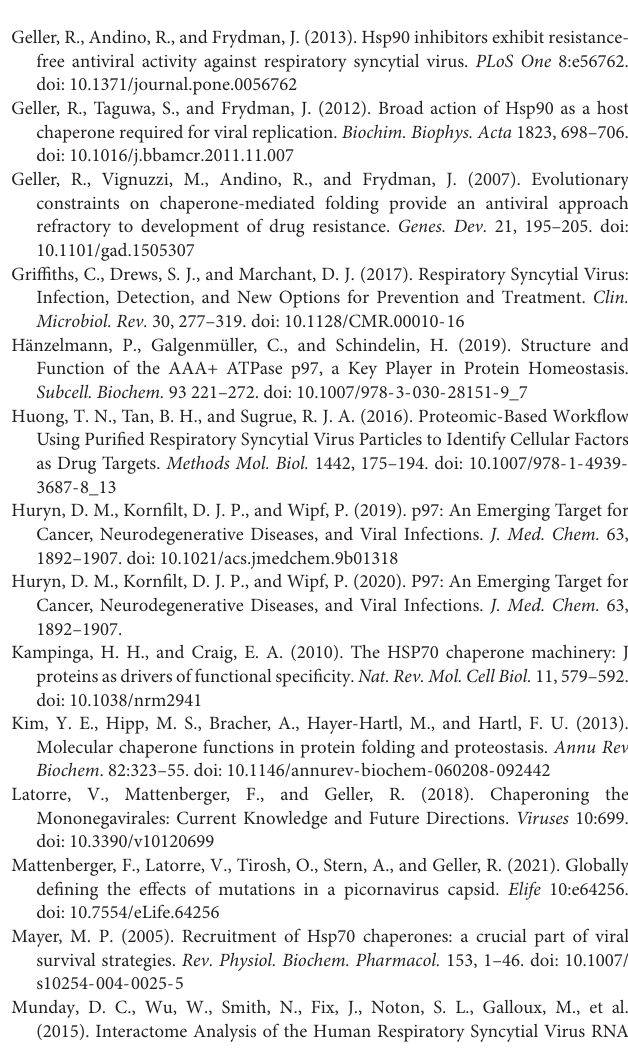
Supplementary Table 2 | Results of the toxicity, knockdown efficiency, and SSMD for evaluated genes. Supplementary Table 3 | esiRNA information for screened genes. Supplementary Table 4 | Primer sequences for evaluation of gene knockdown using qPCR. Supplementary Table 5 | Significant hits from the primary and secondary screen RNAi